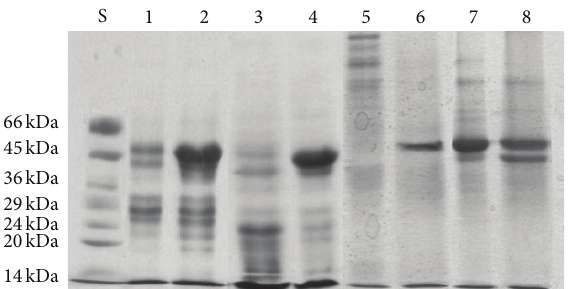
Figure 7: SDS-PAGE analysis of proteins extracted from biomass of Chlorella sorokiniana : 50% ammonium sulfate fractions of control (lanes 1 and 3) and 40 mg ⋅ L −1 selenate-exposed (lanes 2 and 4) cultures, 60% ammonium sulfate fractions of control (lane 5), 40 mg ⋅ L −1 selenate-exposed (lane 6) cultures, 40% ammonium sulfate fractions of control (lane 7), and 40mg ⋅ L −1 selenate-exposed (lane 8) cultures. All lanes were extracted from cells of Chlorella sorokiniana after 120h of cultivation. Lanes 1 to 4 origin from initial cultivation, while lanes 5 to 8 belong to repeated cultivation. Lanes 1 and 2 were loaded with 15 𝜇 g of proteins, lane 3 with 20 𝜇 g, lane 4 with 10 𝜇 g, while lanes 5 to 8 contained 7.5 𝜇 g of proteins each. S = protein ladder (molecular weight marker).